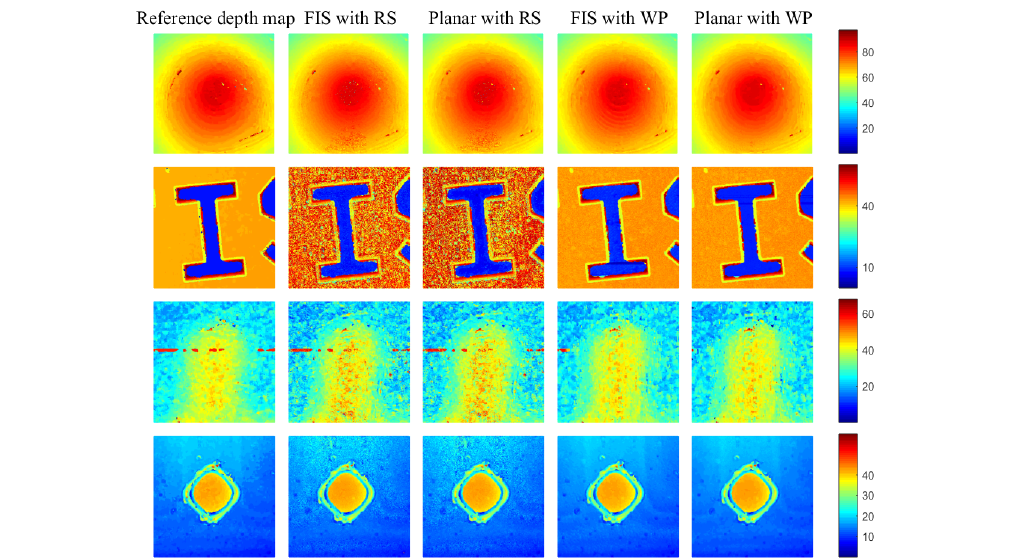
Figure 10. Restored 3D depth map for various SFF methods using various real objects, first row: real cone object, second row: engraved I object, third row: coin object, and fourth row: TFT-LCD filter object. In addition, first column: True depth map, second column: NN.FIS with RS, third column: NN.Planar with RS, fourth column: NN.FIS with WP, and fifth column: NN.Planar with